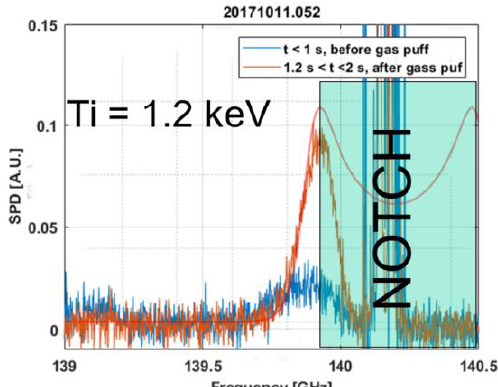
Fig. 1. High density plasma scenario with O2-ECRH and pellet injection. The second row shows the chance of polarizer position for the 3 “start - up” gyrotron beams, when their polarisation was switched from X2 to O2.